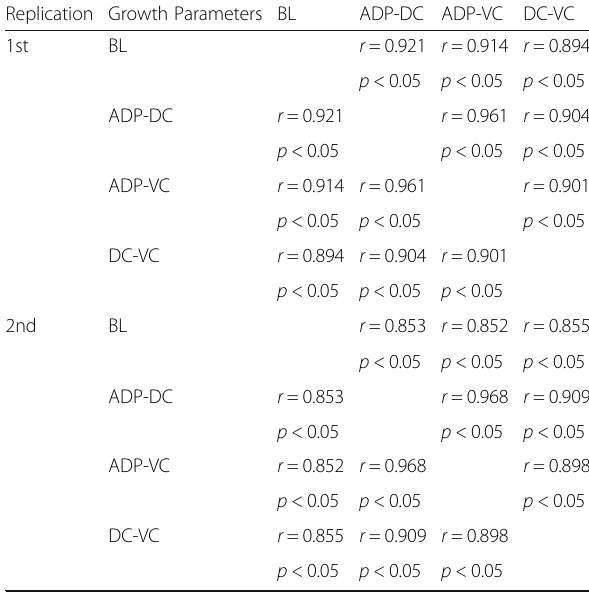
Table 2 Non-parametric correlation analysis using Spearman ’ s rho ( r ) correlation coefficient and p value of relationships between cephalopharyngeal skeleton and body length of